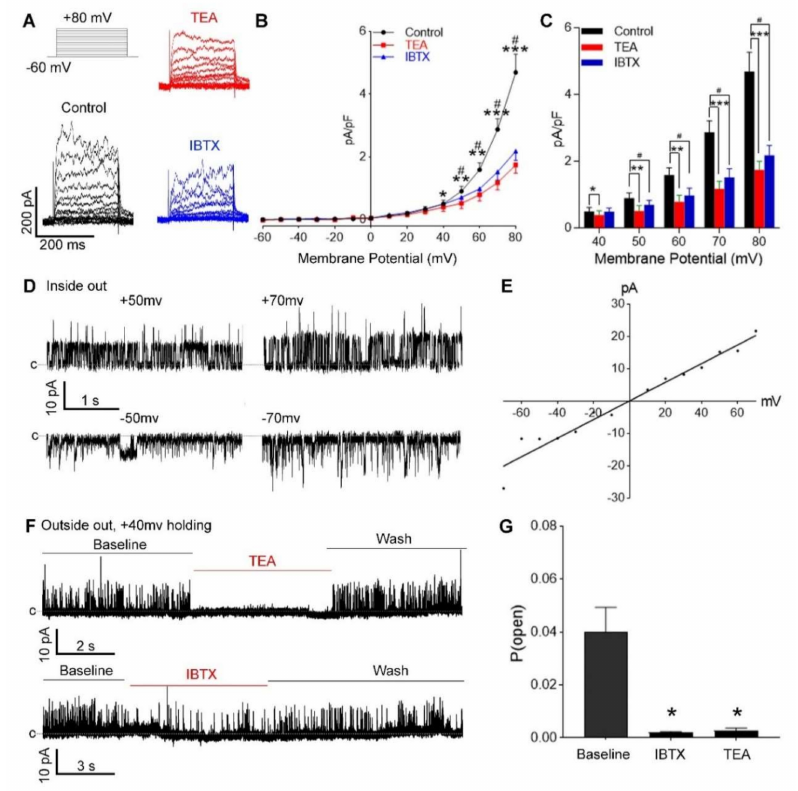
Figure 2. Functional BK Ca channels in primary hUASMC in vitro. ( A ) The top-left figure shows voltage-triggered protocol of the whole-cell patches, in which cells were held at − 60 mV followed by a 10-mV voltage increment until + 80 mV. Representative voltage-dependent current sweeps of cultured hUASMC in control (black), tetraethylammonium (TEA) (1 mM, red), and iberiotoxin (IBTX) (100 nM, blue) groups. ( B , C ) Current density was used to quantify channel activity, illustrated as current / capacitance (pA / pF). Both TEA (red) and IBTX (blue) inhibited ion currents significantly from holding potential of + 40 mV to + 80 mV. # p < 0.05, * p < 0.05; ** p < 0.01; *** p < 0.001; IBTX or TEA vs. control. ( D , E ) Inside-out patch of cultured hUASMC with symmetrical 140 mM K + showed outward currents with holding potential of + 50 and + 70 mV (upper panel in ( D )), and inward currents at − 50 and − 70 mV (lower panel in ( D )), in which a conductance of ≈ 250 pS in the representative trace indicates the presence of big conductance K + channels. ( F ) The big conductance K + channels were sensitive to TEA (upper panel) and IBTX (lower panel) in outside-out patch with 100 nM free Ca 2 + in pipette solution. ( G ) Open probability ( P open ) was used to quantify BK Ca activity. * p < 0.05 vs. baseline. c indicates the close state of